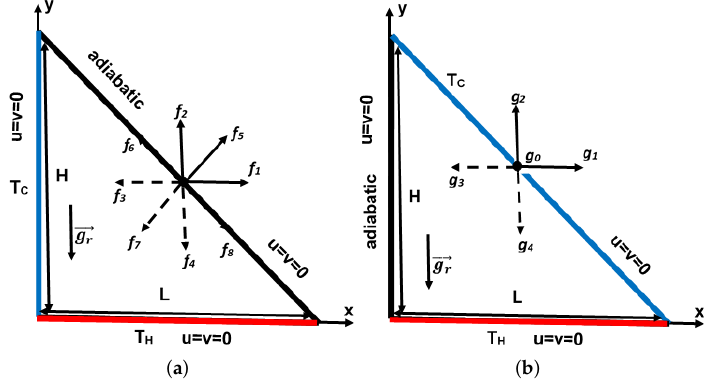
Figure 1. Studied configurations: ( a ) case 1 and ( b ) case